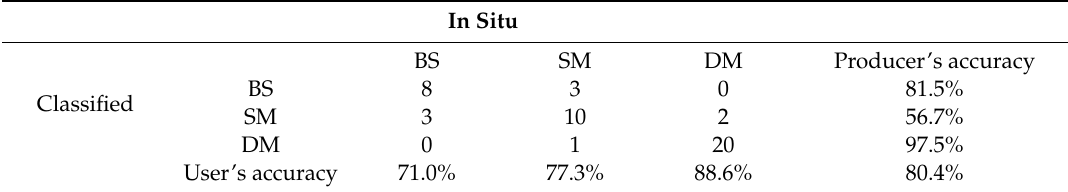
Table 2. Confusion matrix for macrophyte coverage classes mapped from Landsat validated against reference cover estimated from thematic maps. BS = bare sediment, SM = Sparse Macrophyte, and DM = Dense